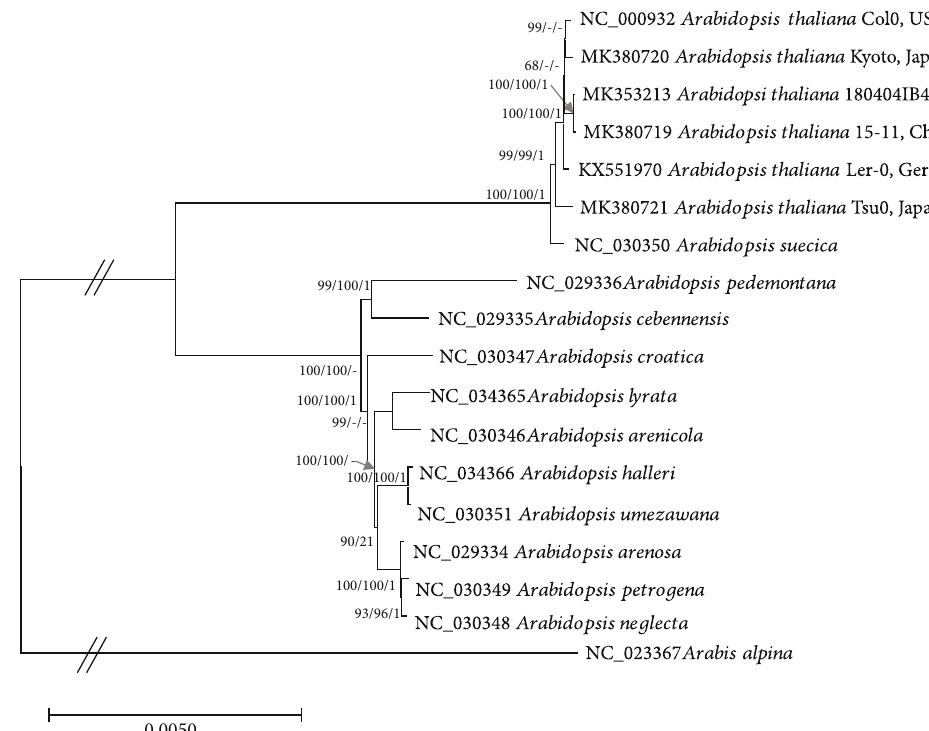
Figure 7: Phylogenetic trees of 18 complete chloroplast genomes of Arabidopsis and Arabis neighbor-joining (bootstrap repeat is 10,000) and maximum likelihood (bootstrap repeat is 1,000) phylogenetic trees as well as Bayesian inference tree (1,100,000 generations) of fi fteen Arabidopsis and one Arabis from Brassicaceae complete chloroplast genomes: six Arabidopsis thaliana (MK353213; 180404IB4, in this study, NC_000932; Col0, KX551970; Ler0, MK380721; Tsu0, MK380720; Kyoto, and MK380719; 15-11), Arabidopsis suecica (NC_030350), Arabidopsis pedemontana (NC_029336), Arabidopsis cebennensis (NC_029335), Arabidopsis croatica (NC_030347), Arabidopsis arenicola (NC_030346), Arabidopsis lyrata (NC_034365), Arabidopsis umezawana (NC_030351), Arabidopsis helleri (NC_ 034366), Arabidopsis arenosa (NC_029334), Arabidopsis petrogena (NC_030349), Arabidopsis neglecta (NC_ 030348), and Arabis alpine (NC_023367). Phylogenetic tree was displayed based on neighbor-joining tree. The numbers above branches indicate bootstrap support values of neighbor-joining and maximum likelihood phylogenetic trees and posterior possibility value of Bayesian inference tree,